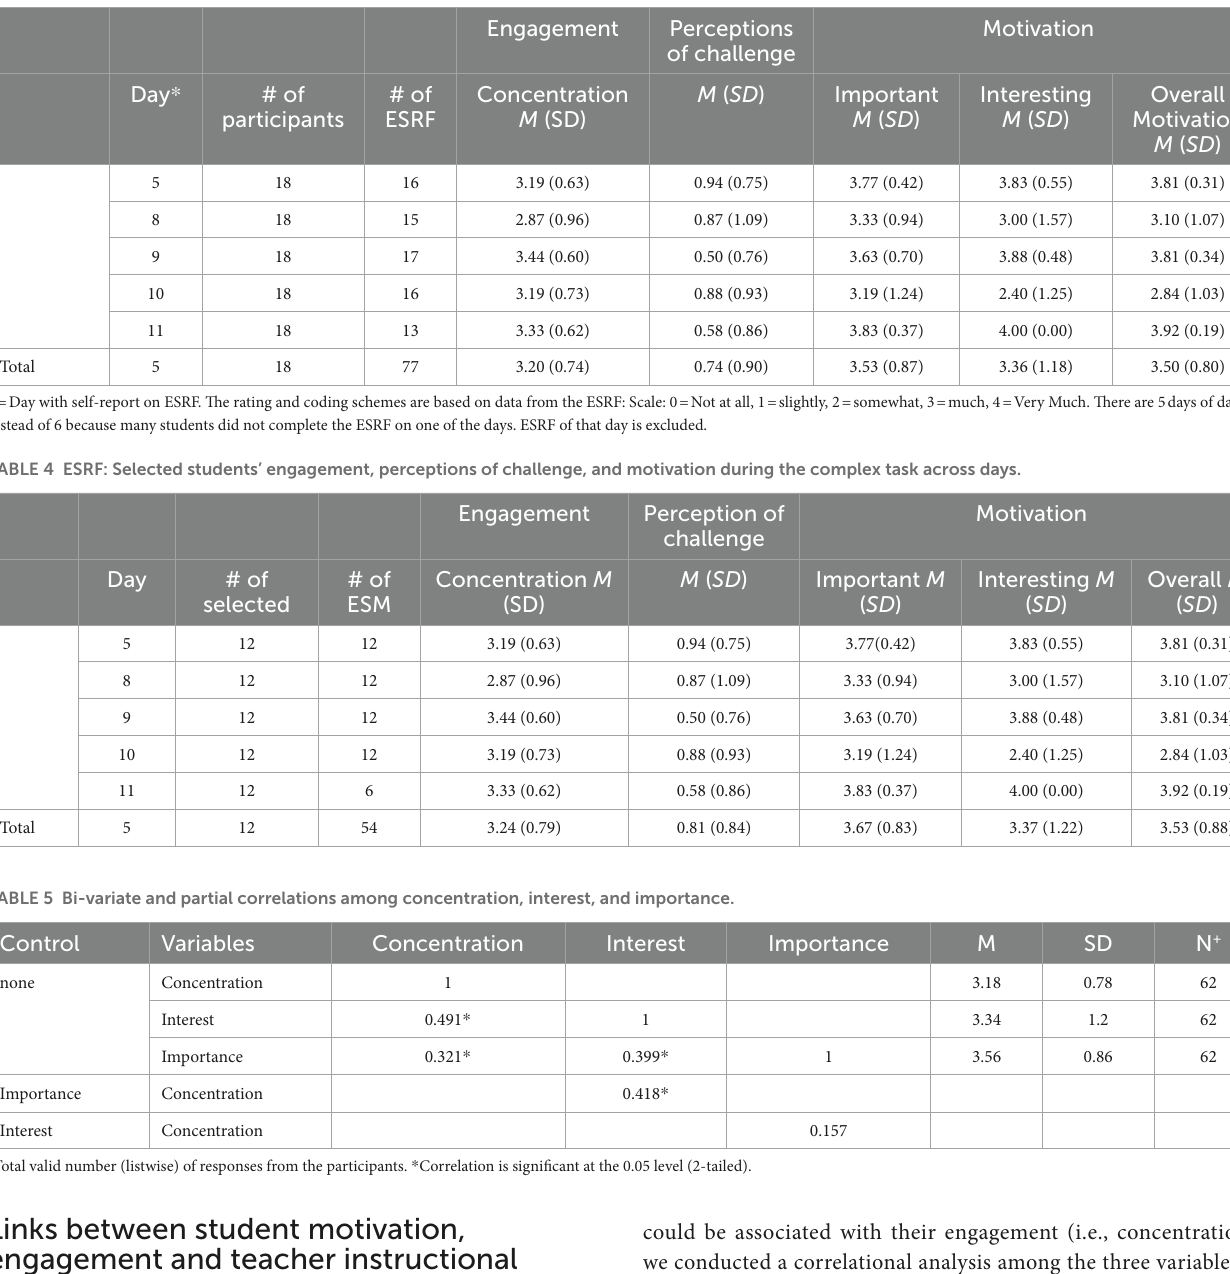
TABLE 3 ESRF: Mean values and standard deviation for students’ experiences of engagement, perceptions of challenge, and motivation during the complex task across days.